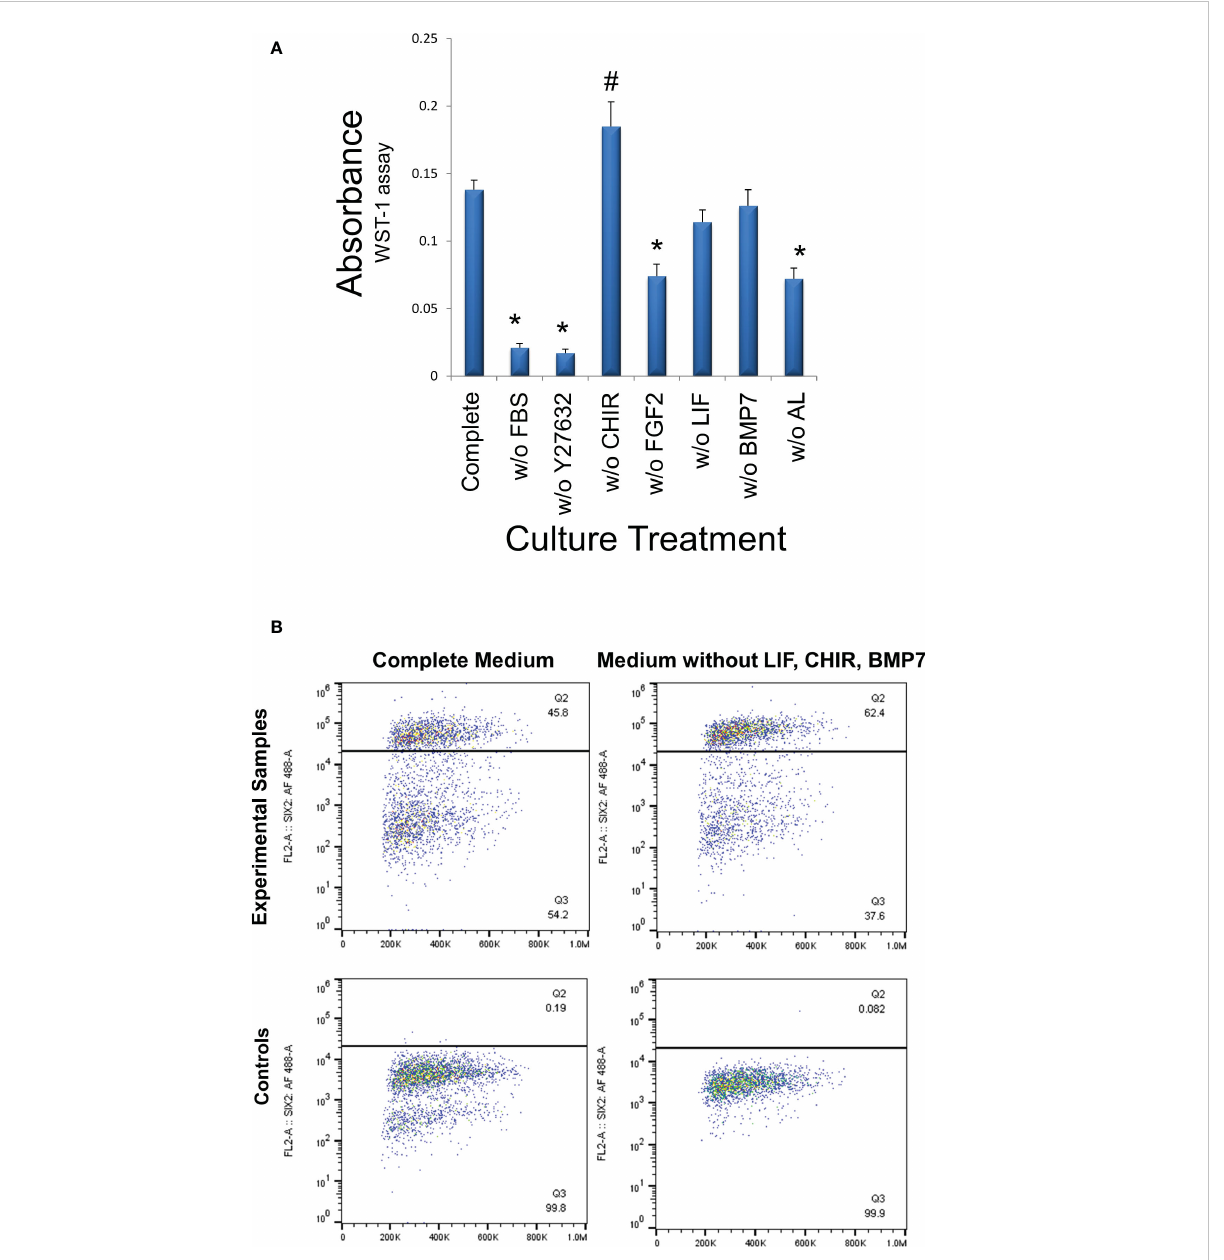
FIGURE 8 Determination of media components essential for cell growth. (A) VUWT13 cells at p5 were cultured in 24-well plates for 4 days with the indicated treatments. Cells were then exposed to the WST-1 reagent for 4 hours and absorbance measured at 440 nm. FBS (1%), ROCK inhibitor Y27632, FGF2, the combination of ALK inhibitors all promote growth in this assay. *Growth is signi fi cantly reduced relative to controls (p<0.05); # Growth is signi fi cantly increased relative to controls (p<0.05). (B) To determine if the tumor phenotype remained stable despite the absence offactors that failed to promote growth, we also quanti fi ed the percentage of P10 SIX2+ cells in cultures by fl ow cytometry, as shown in scatter plots. The percentage of SIX2+ cells did not decrease in cultures that had been maintained in the absence of non-growth-promoting factors despite multiple